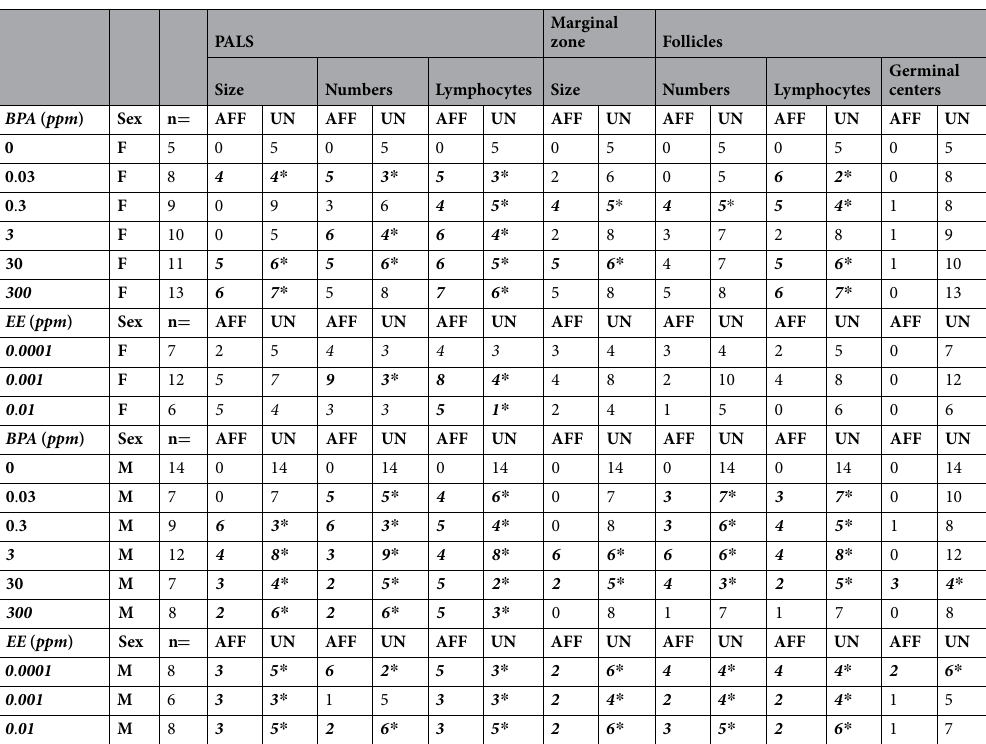
Table 2. Histopathology of Spleen White Pulp. Values are number of samples affected or unaffected. AFF: indicates affected; UN: indicates unaffected. Significant differences compared to same sex control are indicated in bold and italics font and by an *